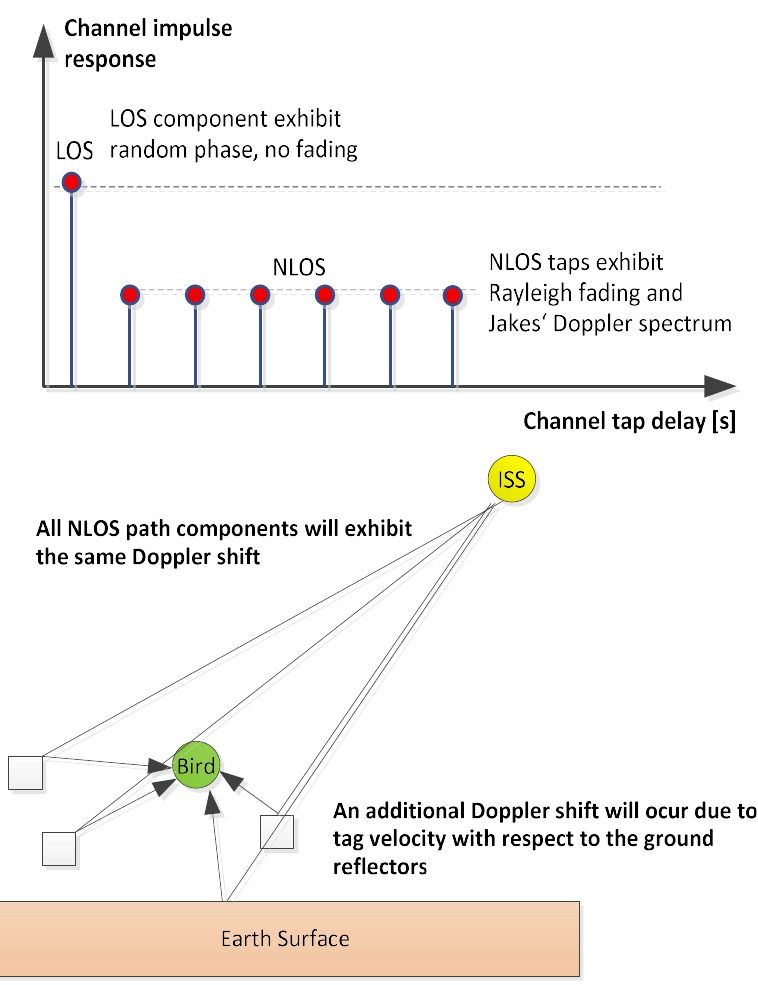
Figure 15. ICARUS channel impulse response modelling.